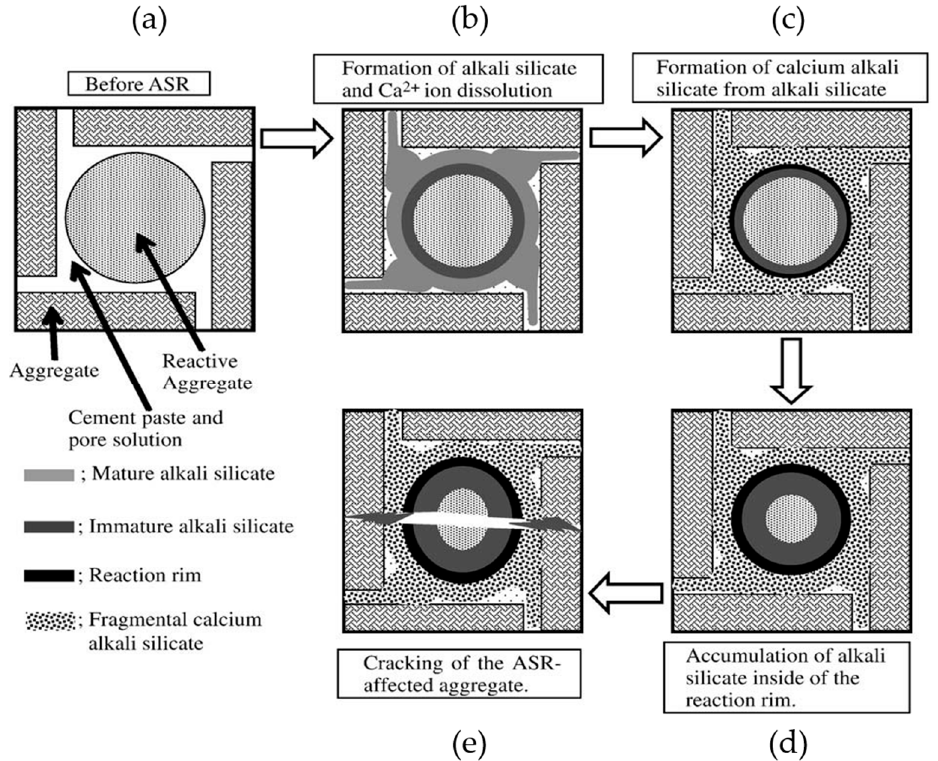
Figure 1. Schematic representation of the mechanism of the alkali-silica reaction (ASR) in concrete, modified from [7]. ( a ) before ASR; ( b ) formation of alkali silicate; ( c ) formation of calcium alkali silicate from alkali silicate; ( d ) accumulation of alkali silicate inside of the reaction rim; ( e ) cracking of the ASR-affected aggregate.